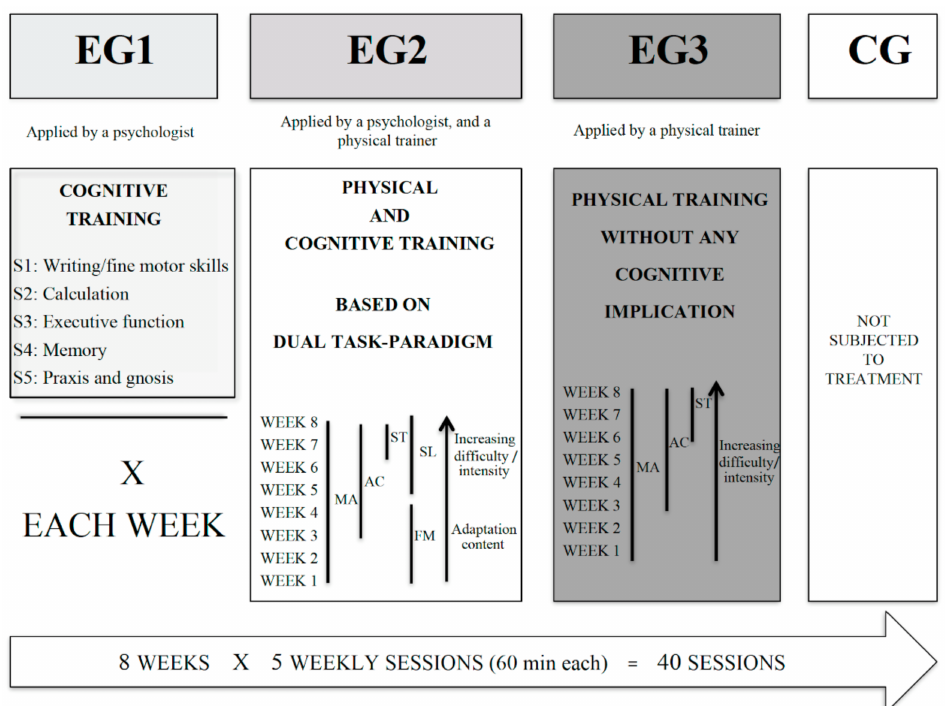
Figure 3. Study design. EG: experimental group; CG: control group; MA: motor aptitude; AC: aerobic capacity; S1; S2; S3; S4, and S5: sessions conducted from Monday (S1) to Friday (S5); ST: strength training; FM: functional movement; SL: